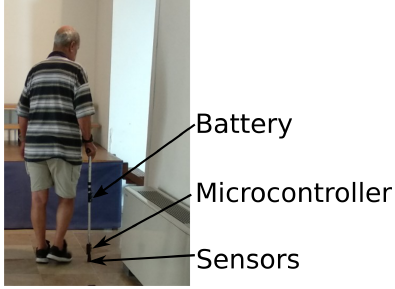
Figure 1. The Smart Cane